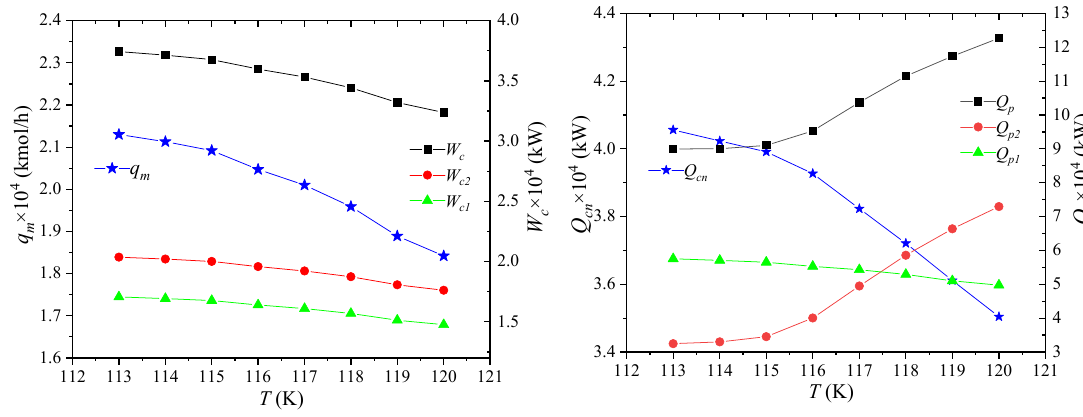
Figure 7. Effects of NG storage temperature on process performance. Figure 7. E ff ects of NG storage temperature on process performance.